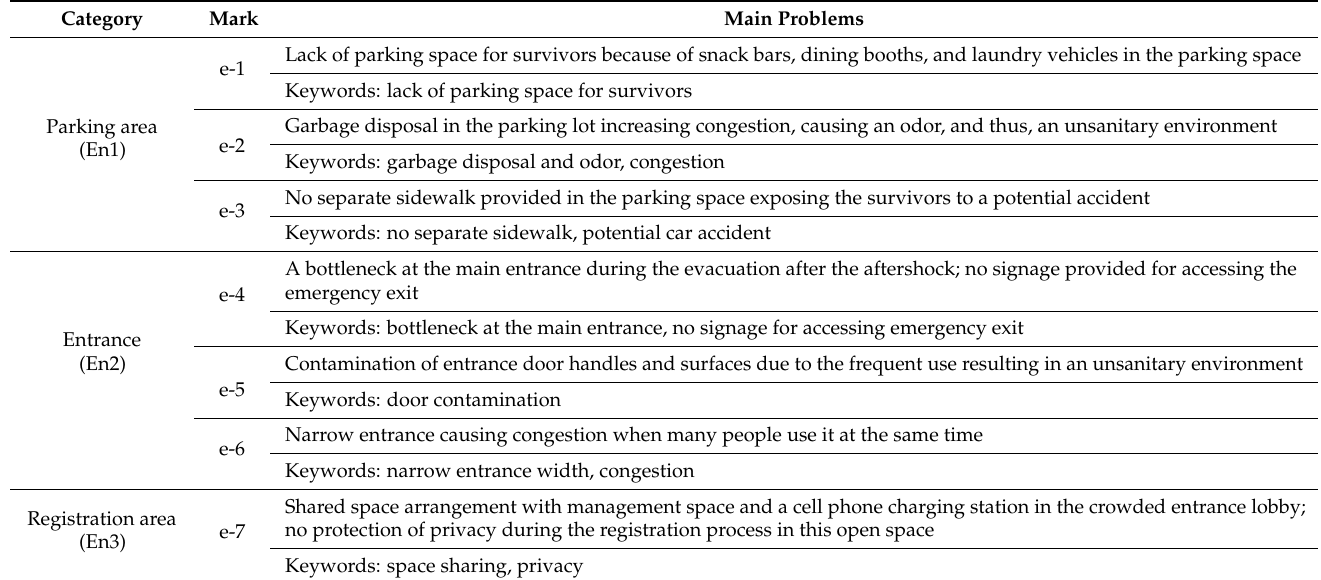
Table 4. Problems identified in the entry